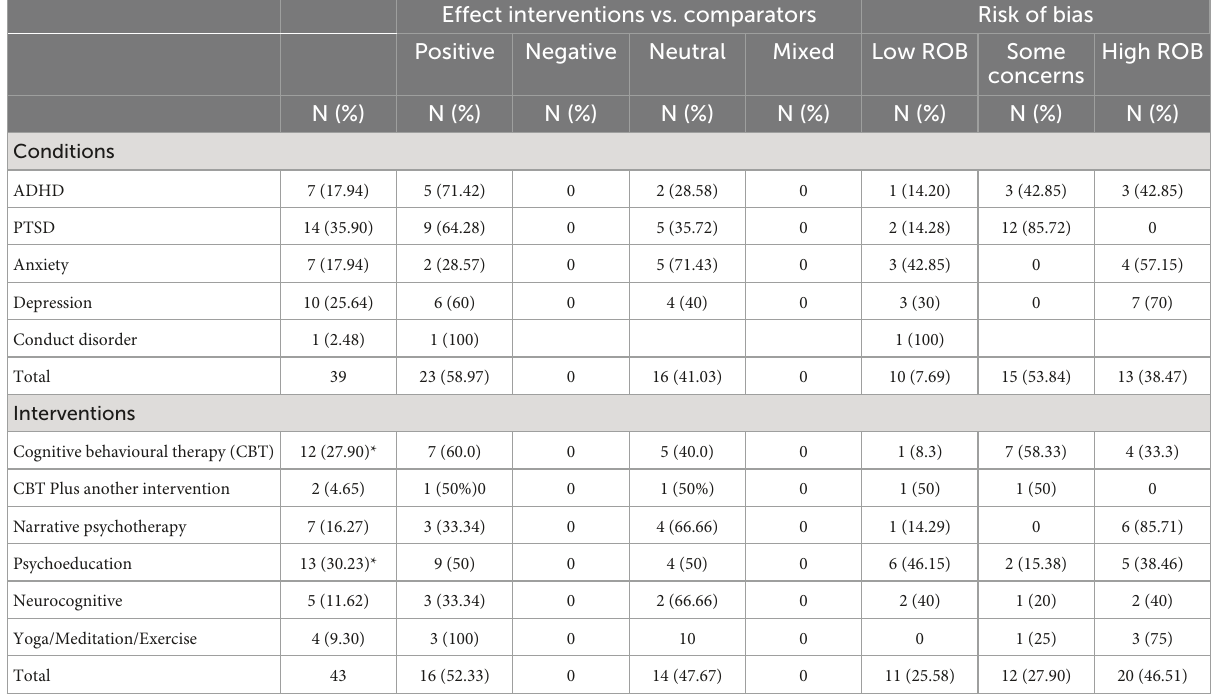
TABLE 3 Summary effect of interventions as compared to control/no intervention, and risk of bias classification by conditions and types of intervention. Effect interventions vs. comparators Risk of bias Positive Negative Neutral Mixed Low ROB Some